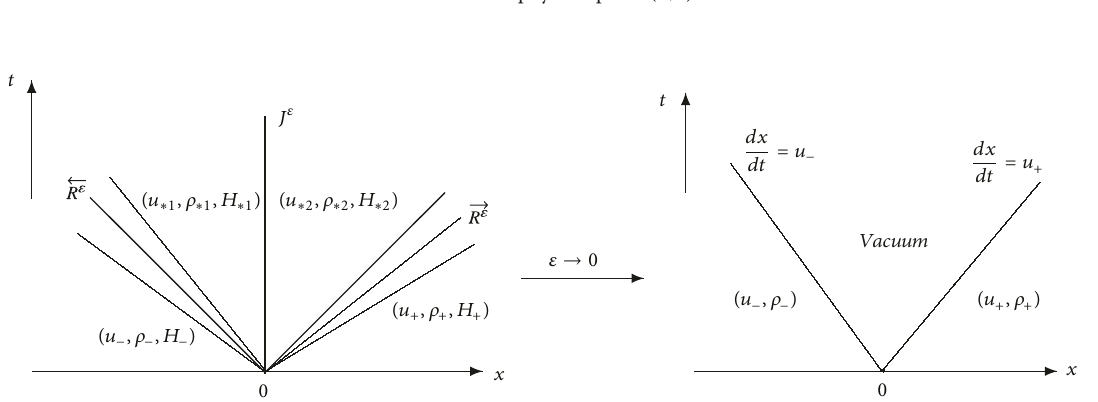
Figure 2: The physical plane (𝑥,𝑡) .